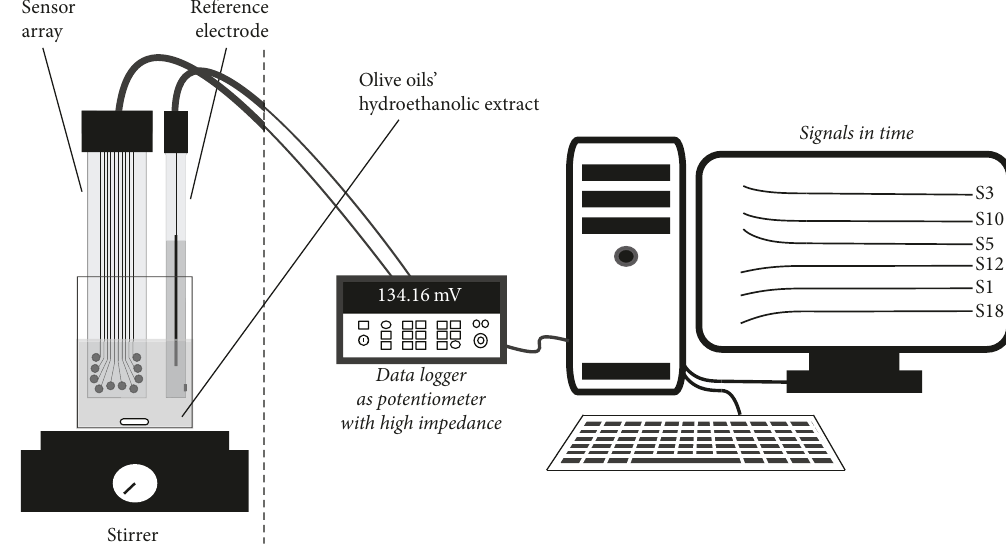
Figure 1: E-tongue setup, including homemade sensor array, data logger, and